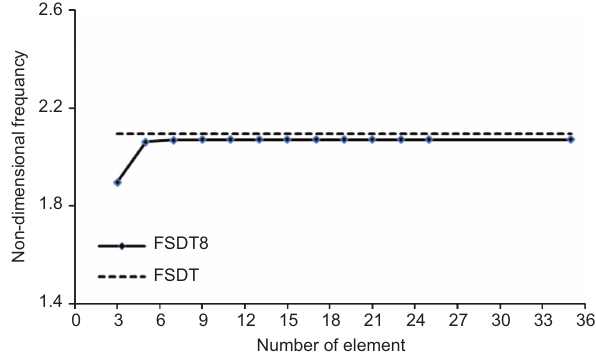
Figure 3 Non-dimensional natural frequency convergence study for a symmetric (30 ° /-30 ° ) composite beam with SS boundary condi- s tion and material I.